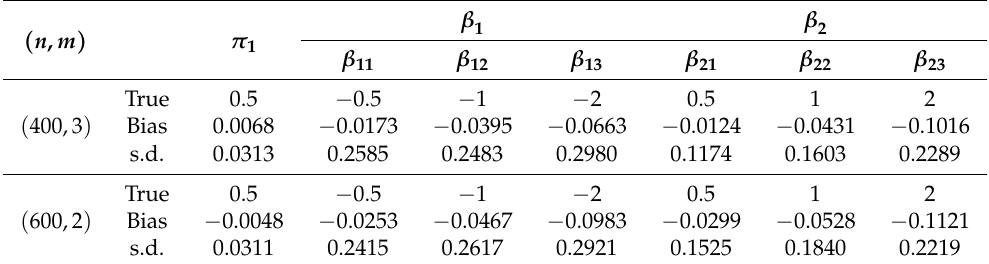
Table 4. The empirical bias and standard error (s.d.) of the estimators ˆ π 1 , ˆ β replications in Example 2.